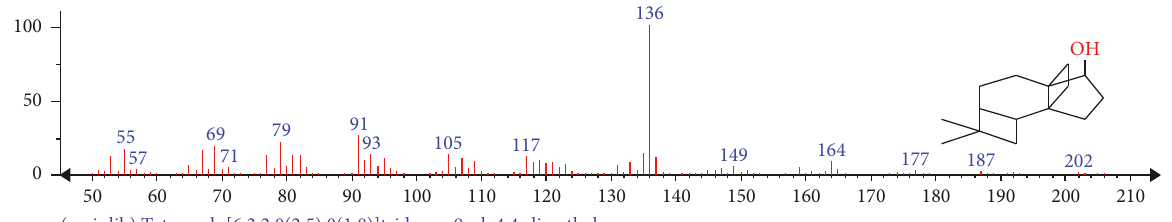
Figure 25: Mass spectrum of compound tetracyclo[6.3.2.0(2,5).0(1,8)]tridecan-9-ol, 4,4-dimethyl- of whole plant hexane fraction of Achillea wilhelmsii (WHFAW).